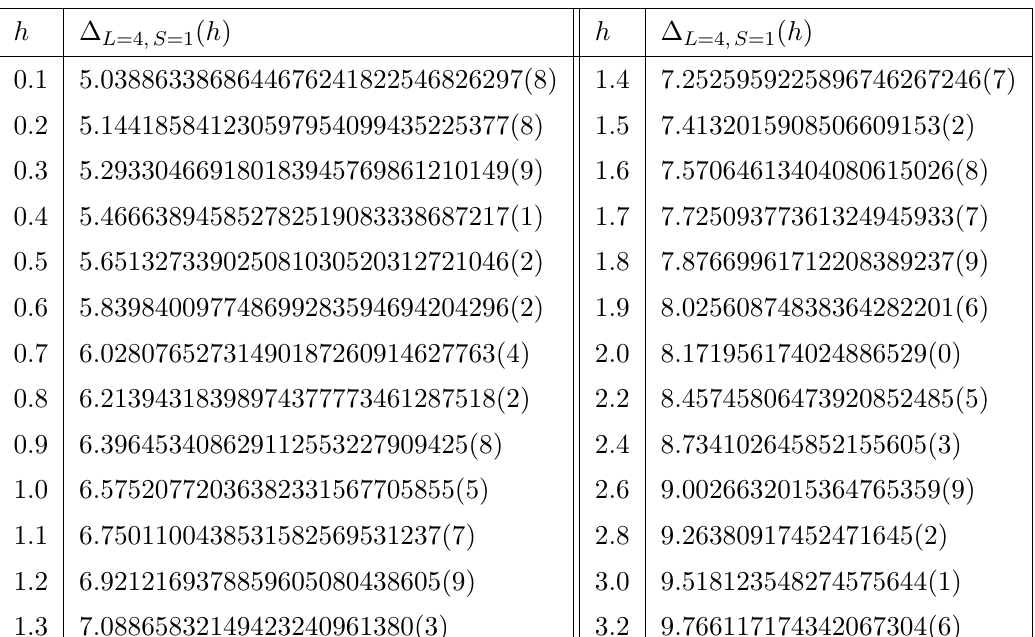
Table 9 . Numerical results for (cid:1) L =4 ;S =1 ( h ) (with K 4 = 2 ; K (cid:22)4 = 0).